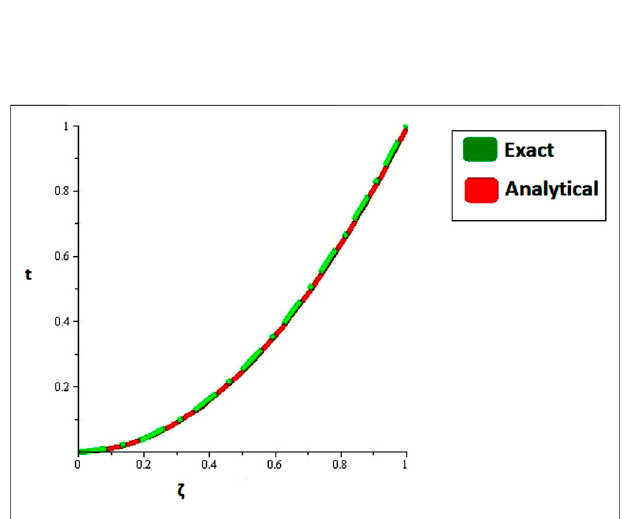
FIGURE 3 | Comparison for the exact and analytical solution at γ =1 for Example 1.